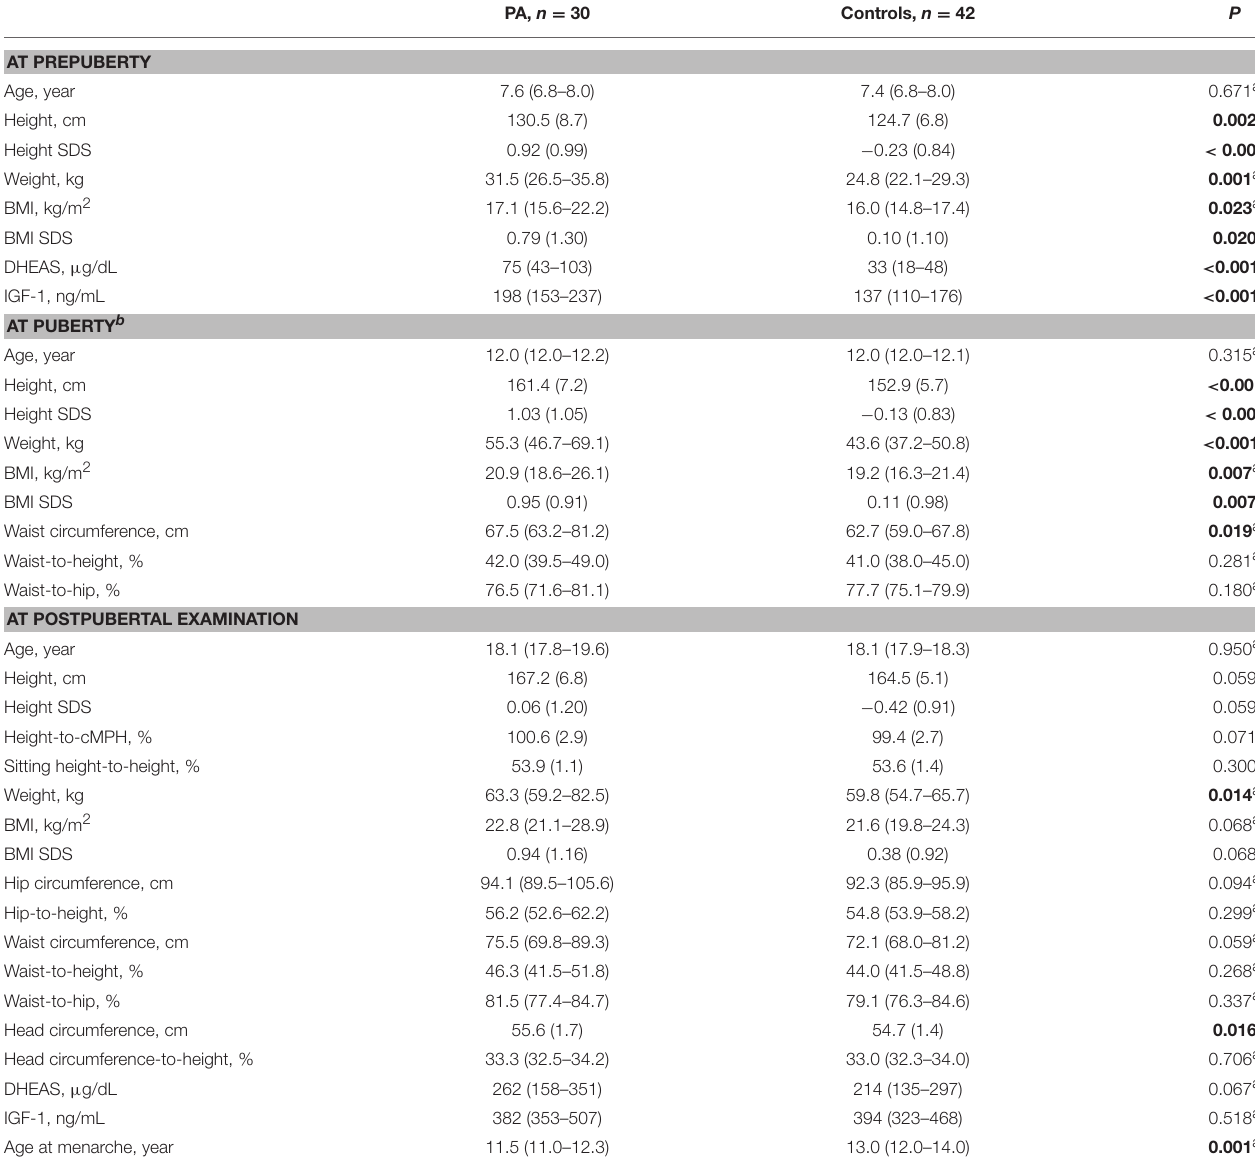
TABLE 2 | Characteristics of the PA and control females throughout the follow-up